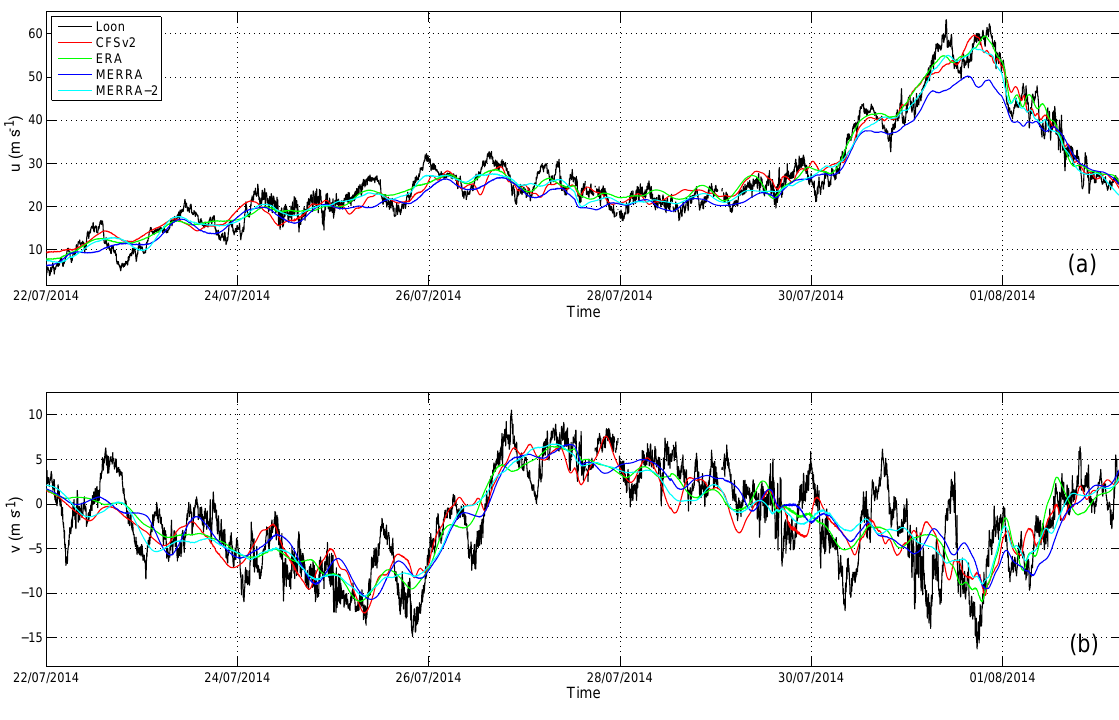
Figure 2. Wind speeds measured from Loon flight no. 263 along with interpolated reanalysis winds. This shows the typical behaviour for comparisons of balloon and reanalysis wind speeds, including the tendency for the balloon winds to oscillate about the reanalysis